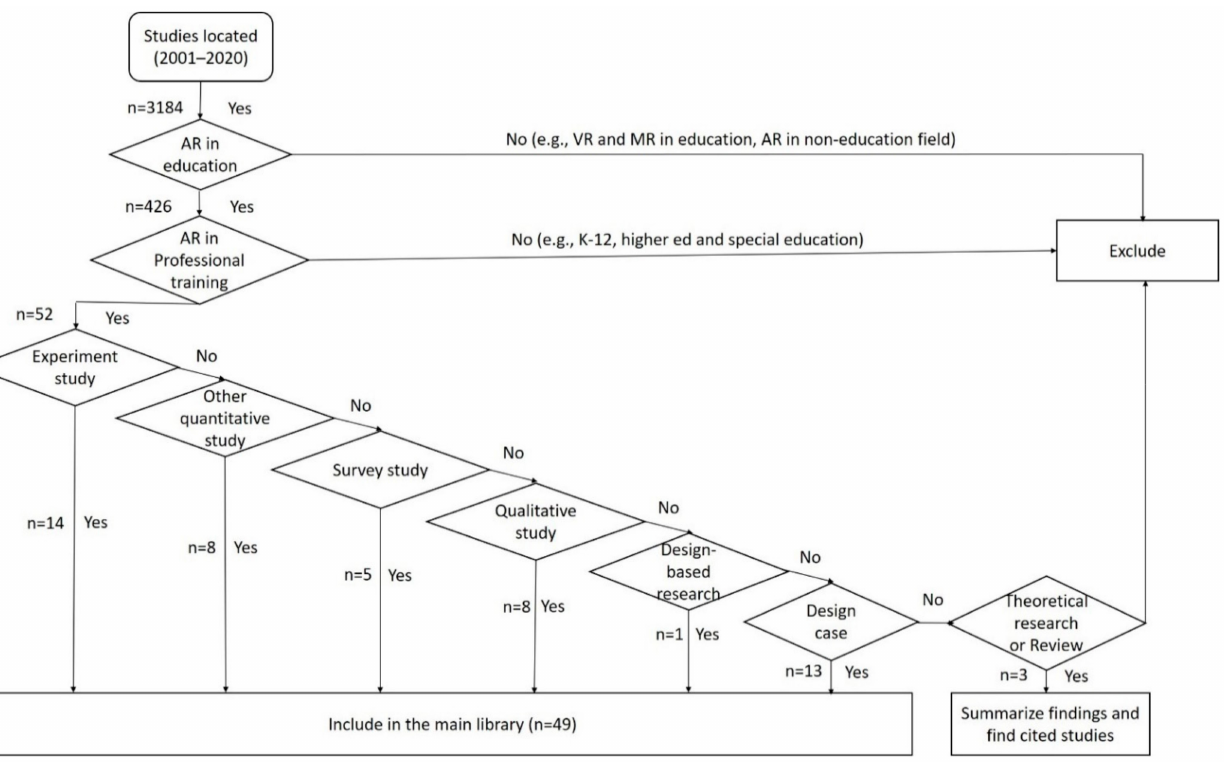
Figure 1. Decision diagram of the manual screening